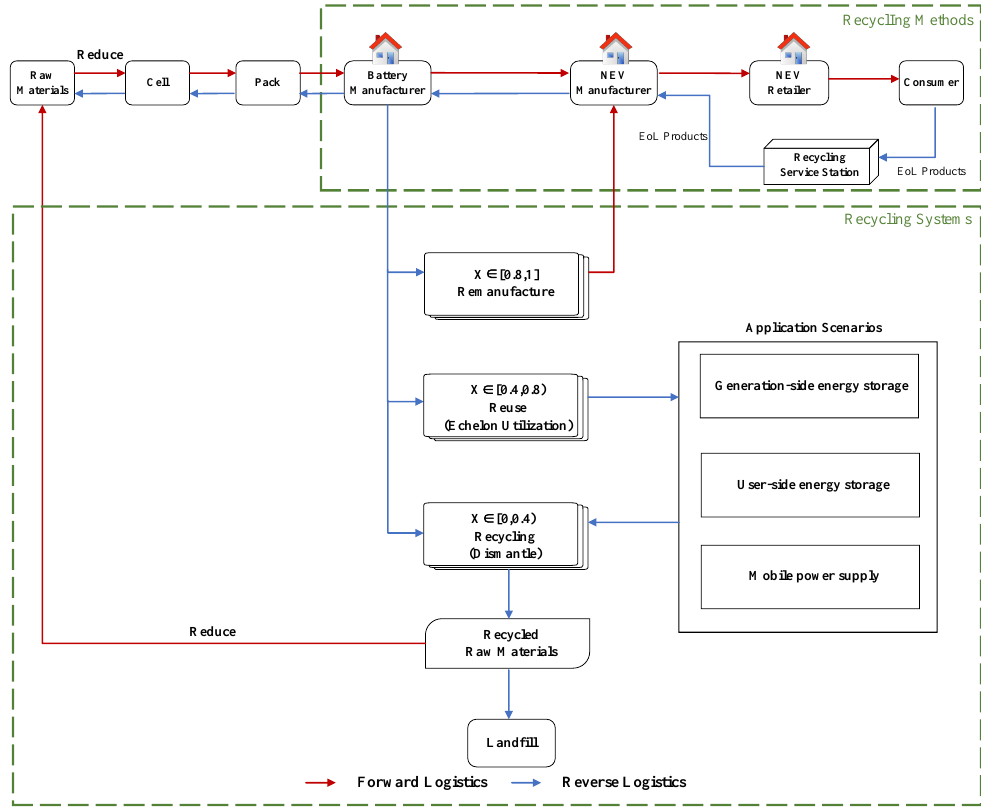
Figure 9. Flowchart of the 4R EoL power battery recycling